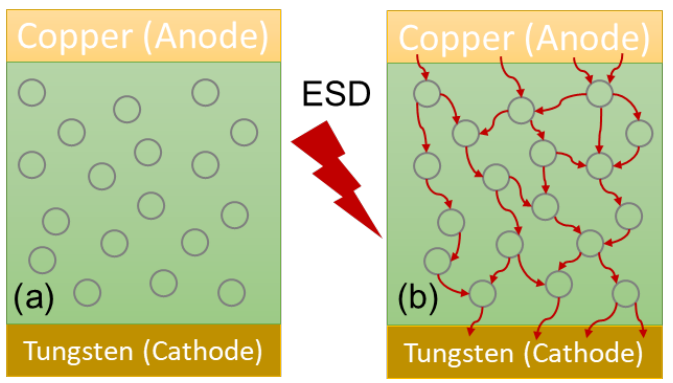
Figure 26. A dispersed local ESD tunneling model was proposed to explain the ultrafast ESD discharge characteristics of a new nano-crossbar array ESD-protection structure: ( a ) Cu ions pre-diffusion and ( b ) local tunneling [48].